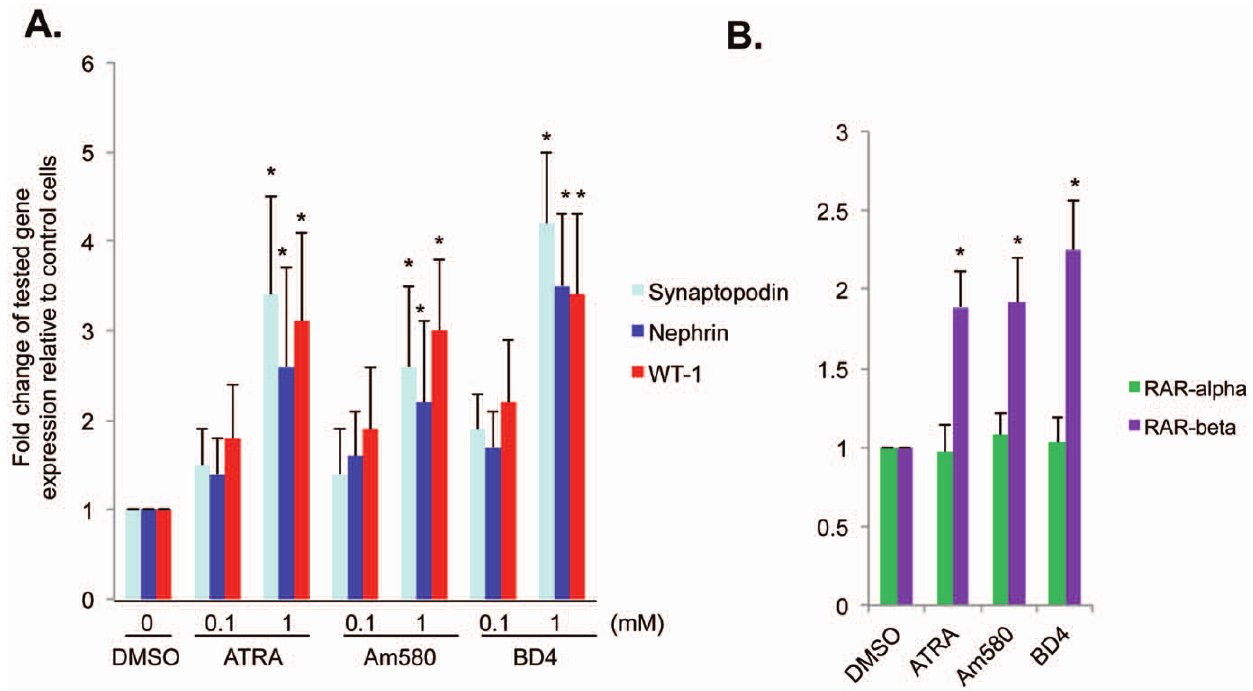
Figure 5. Expression of podocyte differentiation markers in vitro. A. Mouse podocytes cultured at 37 u C for 10 days and then stimulated with either ATRA, or Am580, or BD4 at 0.1 m M and 1 m M for 24 hours in serum free medium. Total RNA was extracted and analyzed by real-time PCR to determine the expression of podocyte differentiation markers (synaptopodin, nephrin, and WT-1). B. Podocytes stimulated with either ATRA, or Am580, or BD4 at 1 m M for 24 hours in serum free medium. Real-time PCR analysis of RAR a and RAR b expression were performed. The ratios of these genes normalized to GAPDH expression are expressed. N=4, p* , 0.01 compared to cells treated with DMSO.